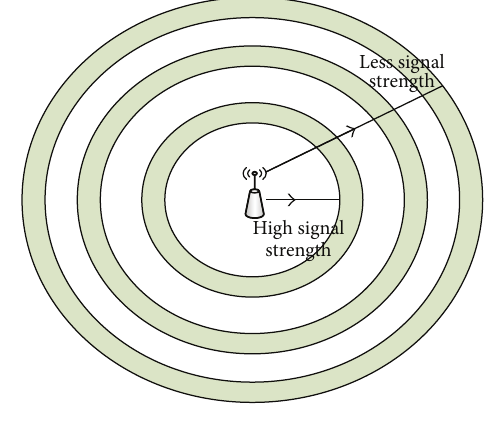
Figure 1: Signal strength pattern.